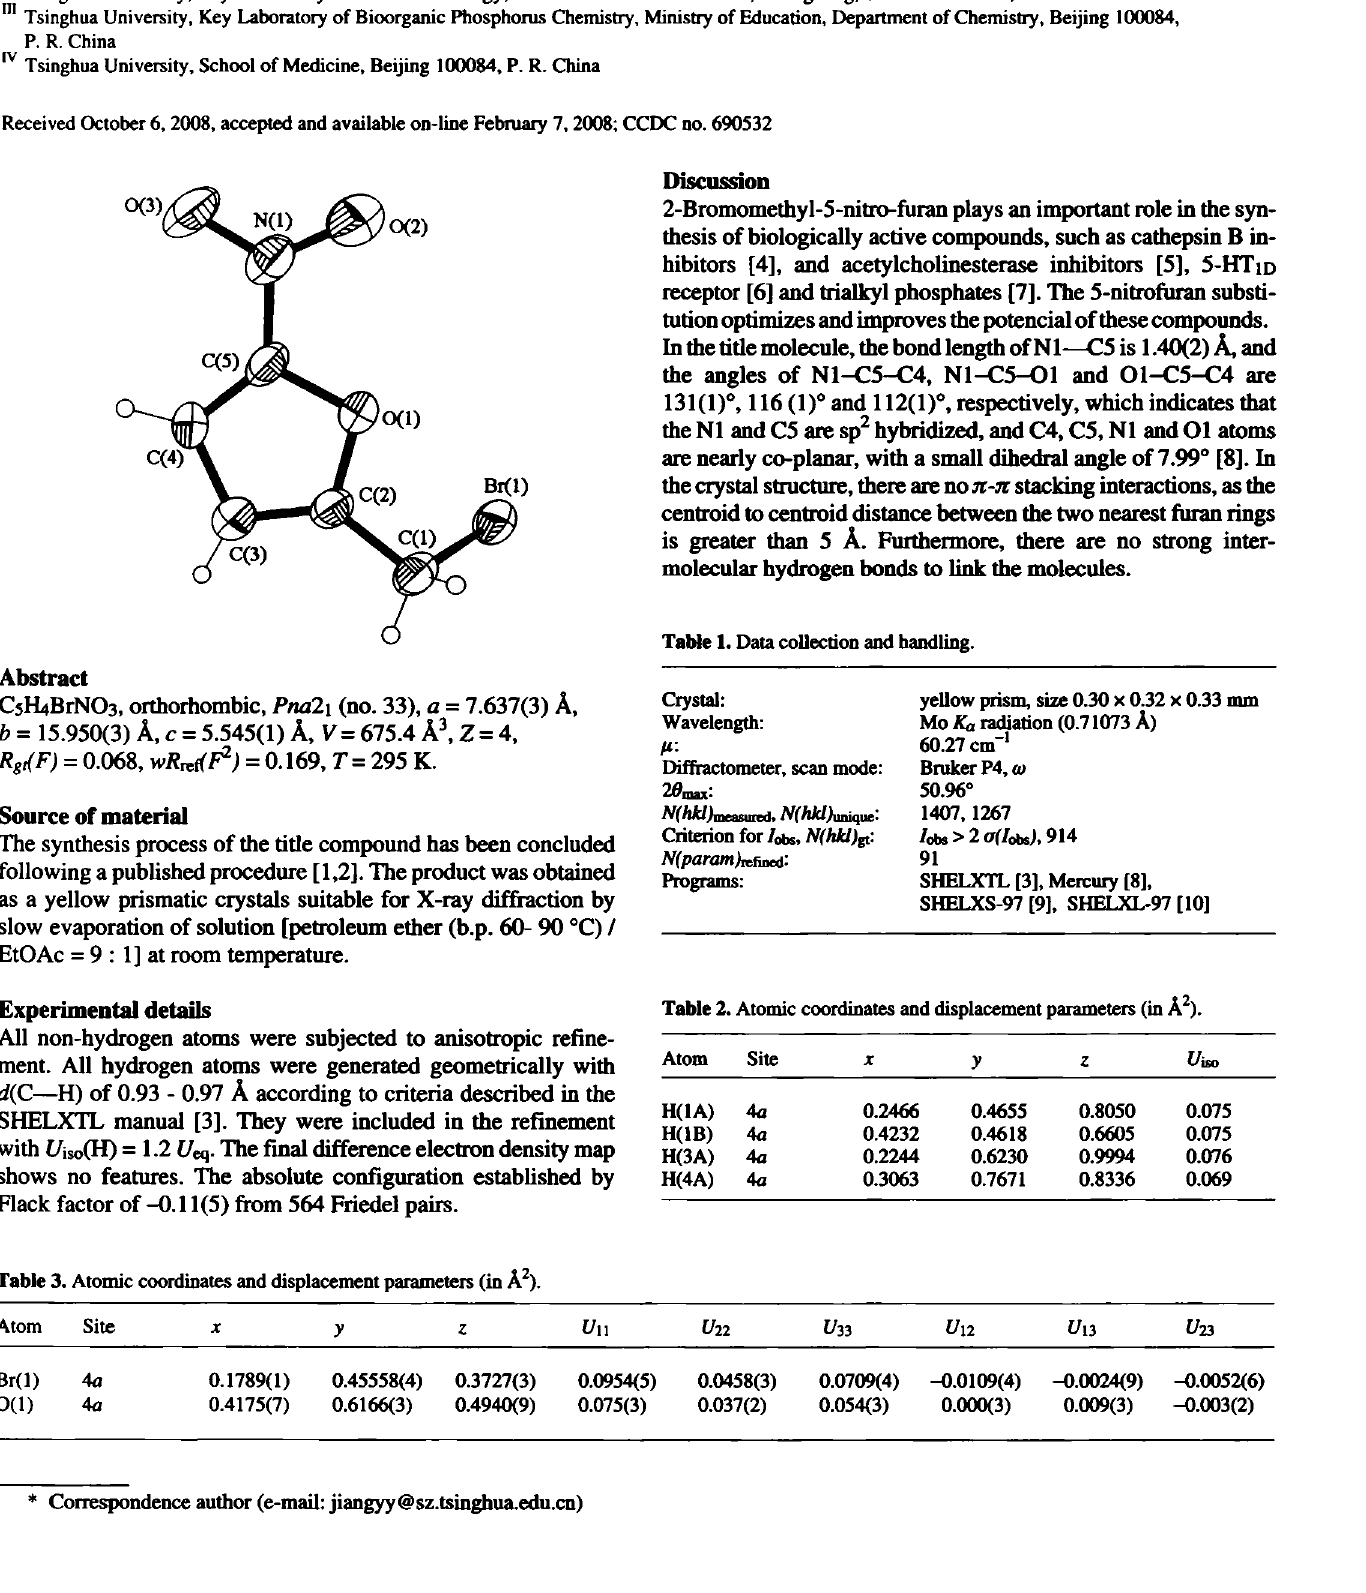
Table 3. Atomic coordinates and displacement parameters (in Â 2